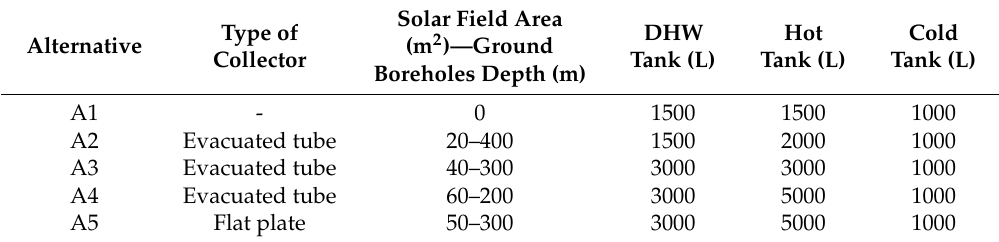
Table 7. Different alternatives simulated with solar field, ground boreholes, and storage tank dimensions (all considering sensible (water) storage).